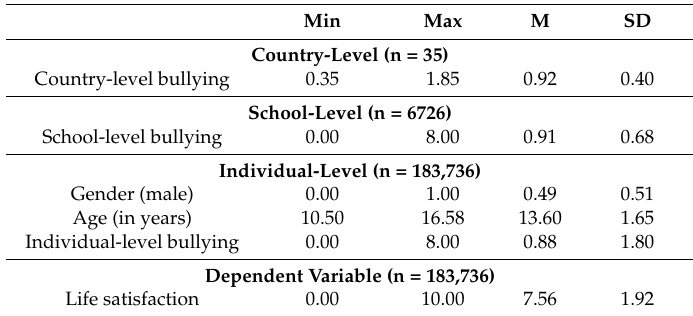
Table 1. Descriptive statistics for country-level and individual-level predictors of life satisfaction for 11- to 15-year-old students in 35 countries, HBSC